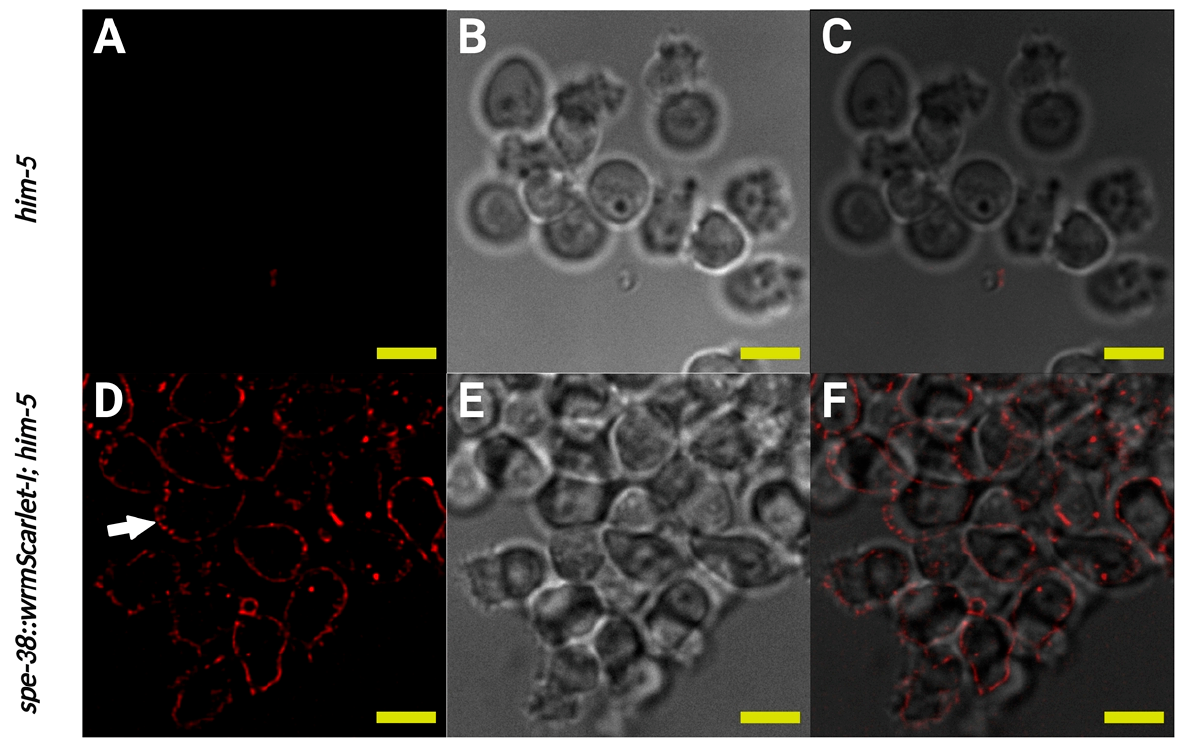
Figure 4. SPE-38::wrmScarlet-I visualized by red fluorescent signal localizes to fused MOs, the cell body and pseudopod plasma membranes in spermatozoa. ( A – C ) Imaging of the same in vivo activated control spermatozoa dissected from mated hermaphrodites. ( A ) Single confocal section of control spermatozoa. ( B ) Bright field image of control spermatozoa. ( C ) Merge of ( A , B ). ( D – F ) Imaging of spe-38::wrmScarlet-I ; him-5(e1490) in vivo activated spermatozoa dissected from mated hermaphrodites. ( D ) Single confocal section of spe-38::wrmScarlet-I ; him-5(e1490) spermatozoa. White arrow indicates fused MOs in a spermatozoa. ( E ) Bright field image of spe-38::wrmScarlet-I ; him-5(e1490) spermatozoa. ( F ) Merge of ( D ) and ( E ). Yellow scale bars, 5 µm.